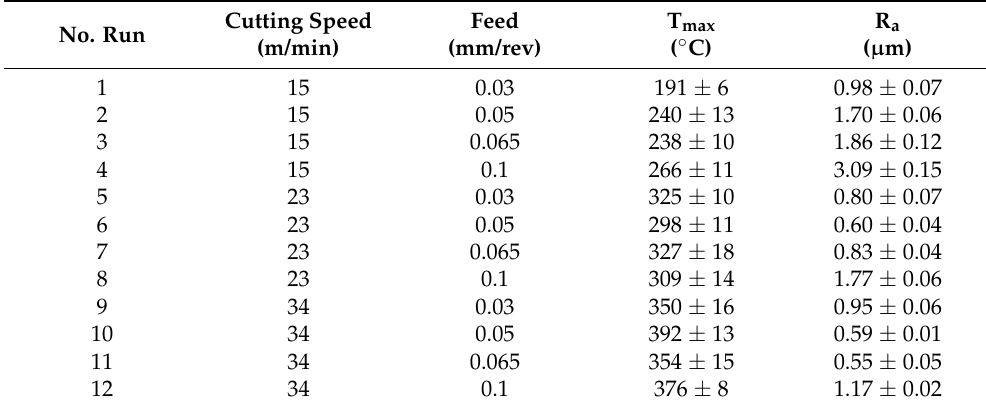
Table 4. Maximum temperature (T max ) detected in the cutting region and surface average roughness of the machined parts (R a